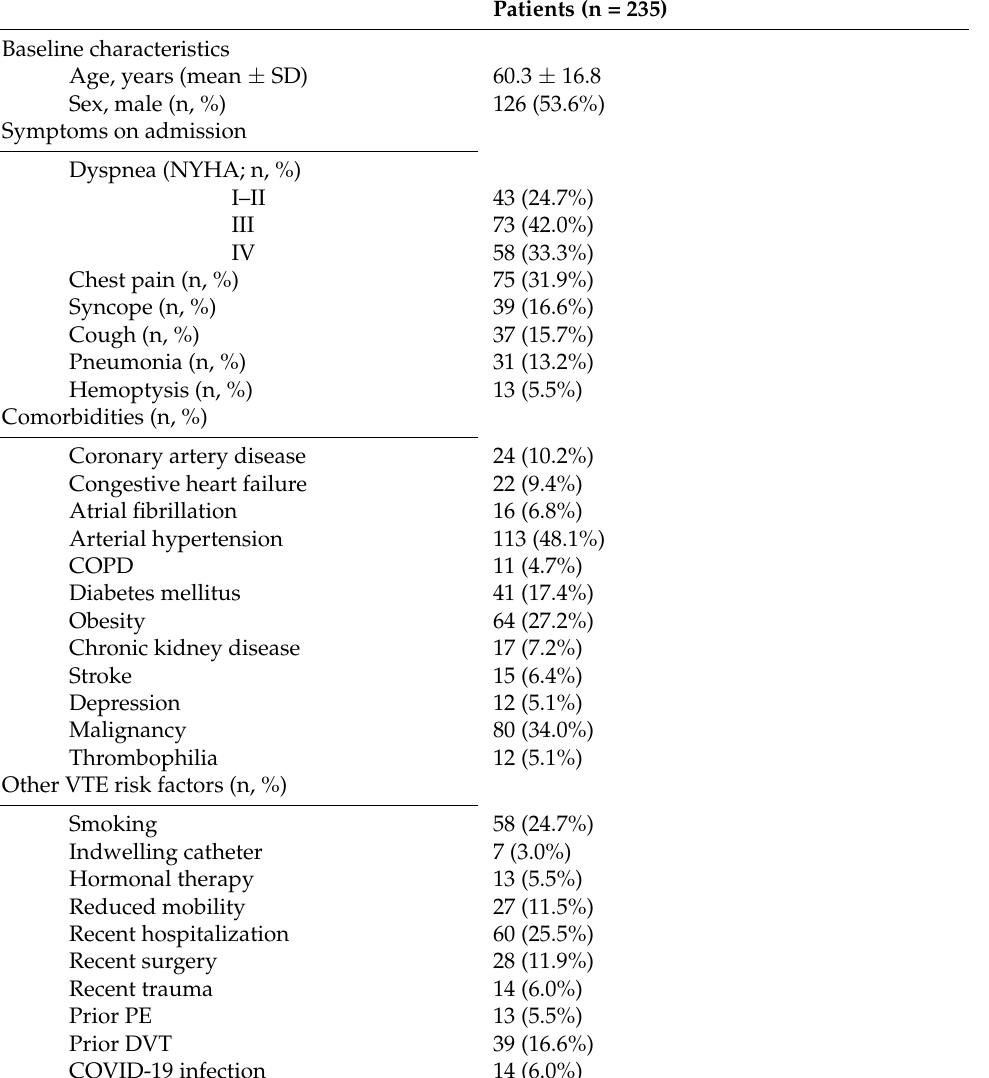
Table 1. Baseline characteristics of PE